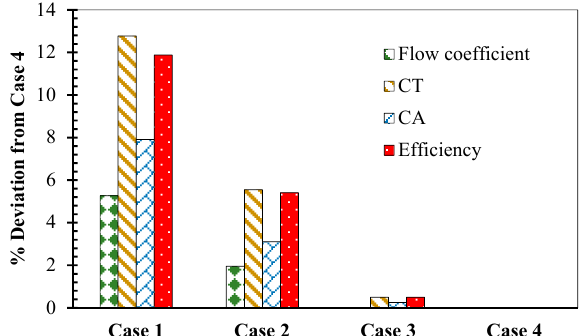
Figure 4. Results of grid independency study considering case 4 as the reference.